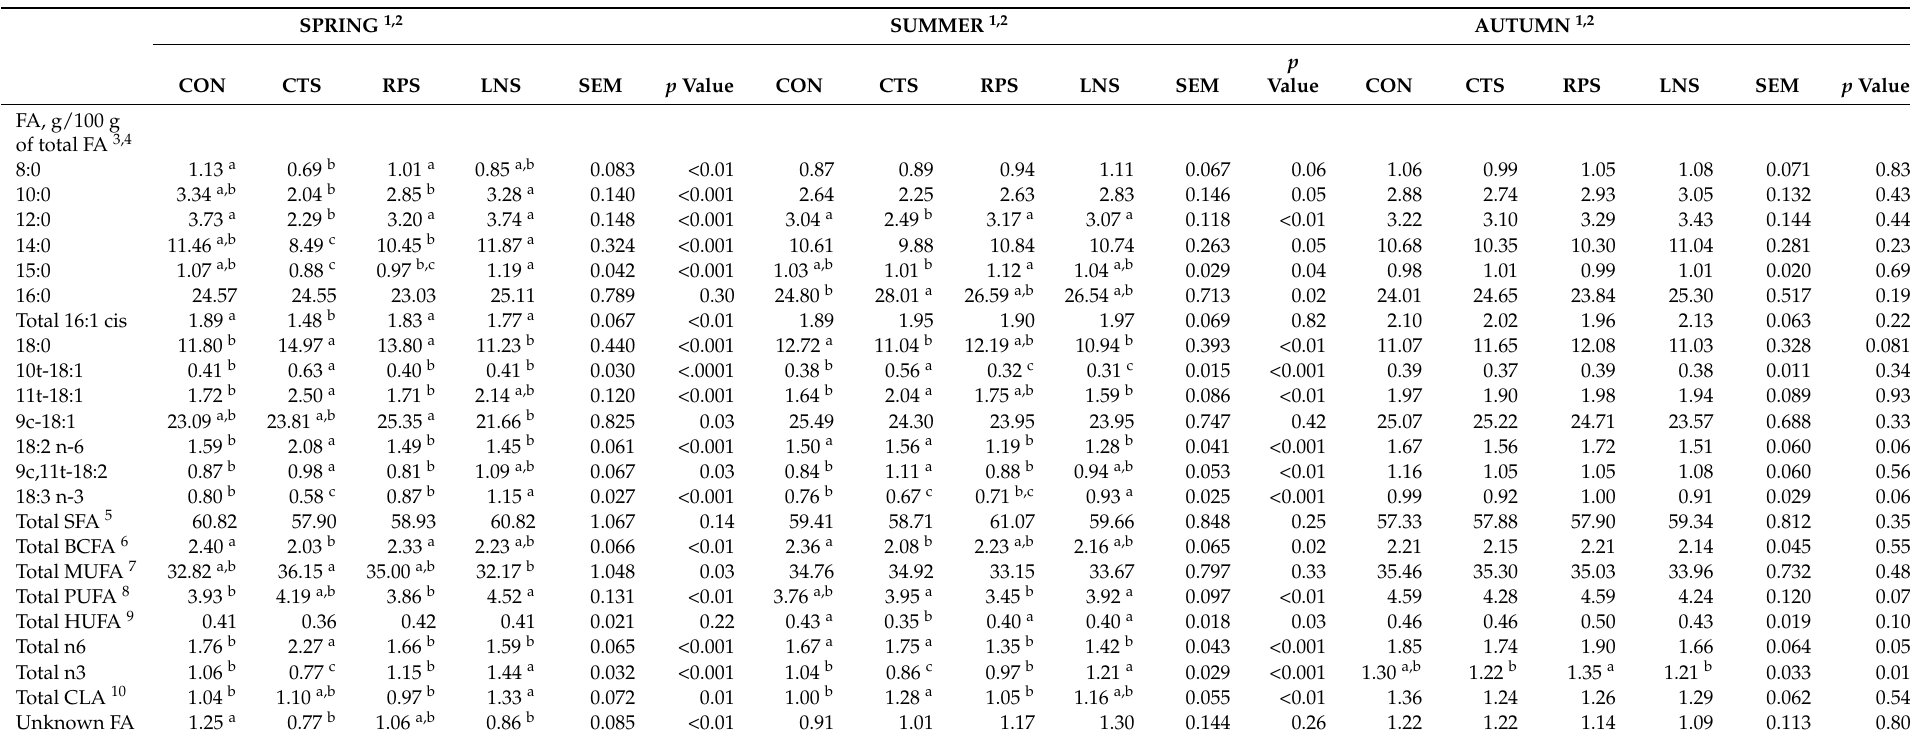
Table 4. Effect of oilseed supplementation on milk fatty acid (FA) composition of lactating dairy cows on pasture in spring and summer. SPRING 1,2 SUMMER